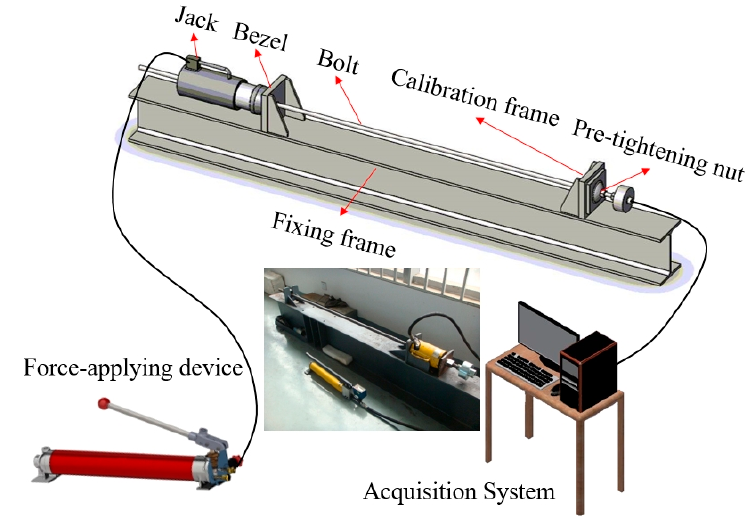
Figure 7. Calibration system of FBG force measuring bolt.